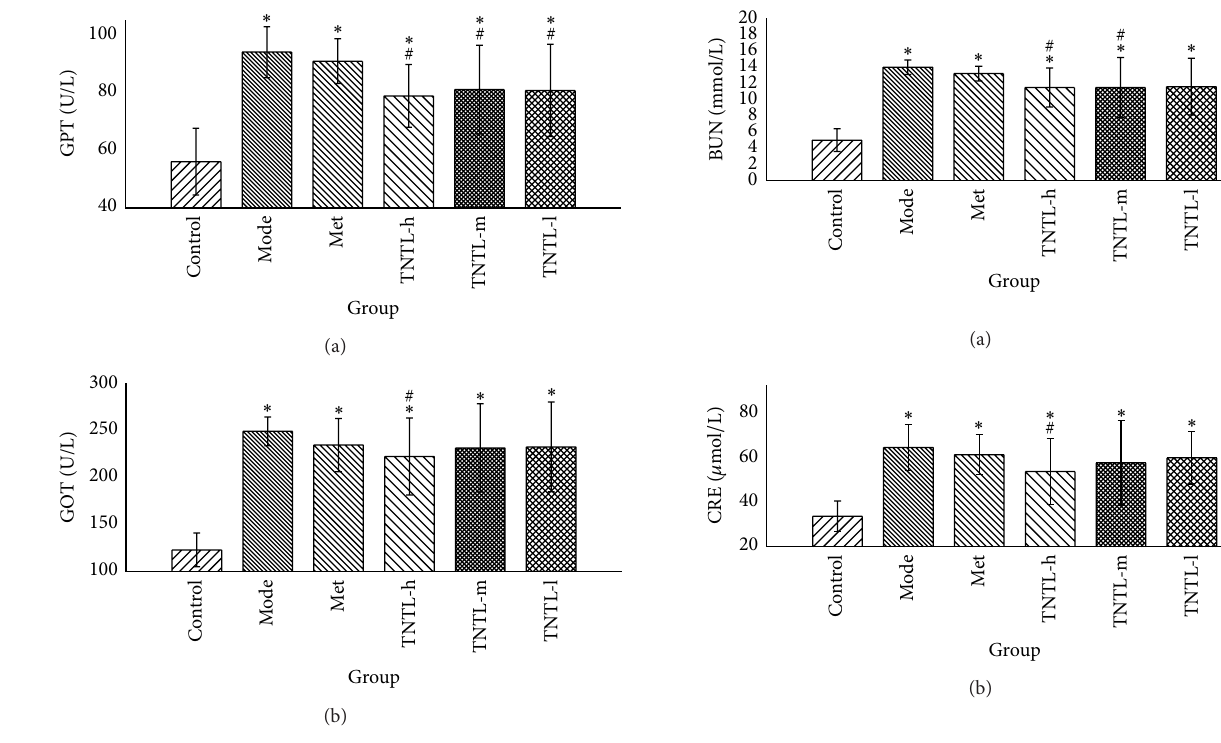
Figure 7: Liver function in db/db mice. TNTL (TNTL-h, m, l = 3.6 g, 1.8 and 0.9 g/kg b.w., resp.) administration resulted in reduced plasma levels of GPT (a) and GOT (b), compared to DM controls. The TNTL groups (3.6 g/kg) show significantly reduced GTP and GOP (16% and 11%, resp.), compared to DM controls. Control: C57BL, DM: db/db mice with untreated, Met: db/db mice treated with metformin, and TNTL-h, m, l: db/db mice treated with 3.6g, 1.8 and 0.9g/kg b.w., respectively. # 𝑃 < 0.05 compared with DM group. ∗ 𝑃 < 0.05 compared with control group.